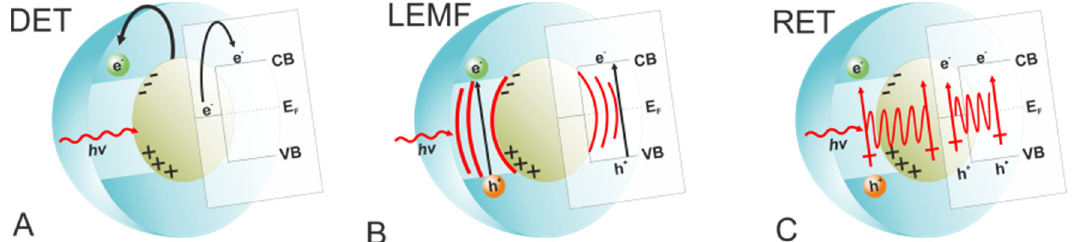
Figure 20. Various mechanism of plasmon energy transfer from metal to the semiconductor. ( A ) Direct electron transfer (DET) of hot electrons, ( B ) local electromagnetic field enhancement (LEMF) of the semiconductor charge separation process, ( C ) resonant energy transfer